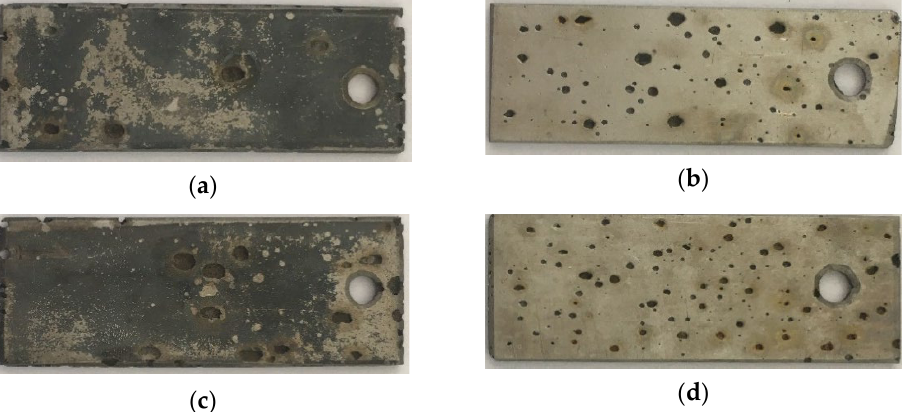
Figure 5. The sensitizied specimens after 24 h exposure in 1 M Cl − solution (represented by 5 wt % FeCl 3 solution): ( a ) S 20; ( b ) SP 20; ( c ) S 50; ( d ) SP 50.